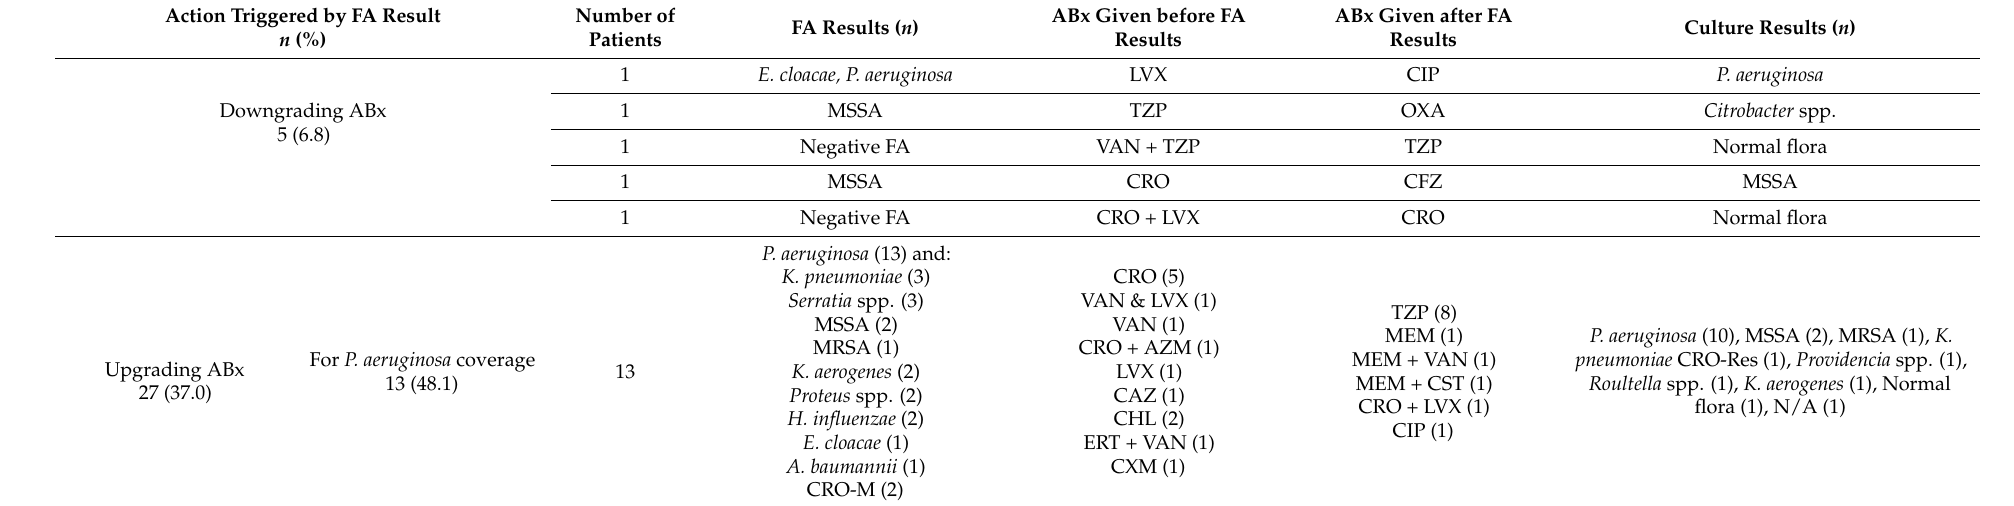
Table 6. Cases in which antimicrobials were downgraded, upgraded, or left unchanged as result of FA